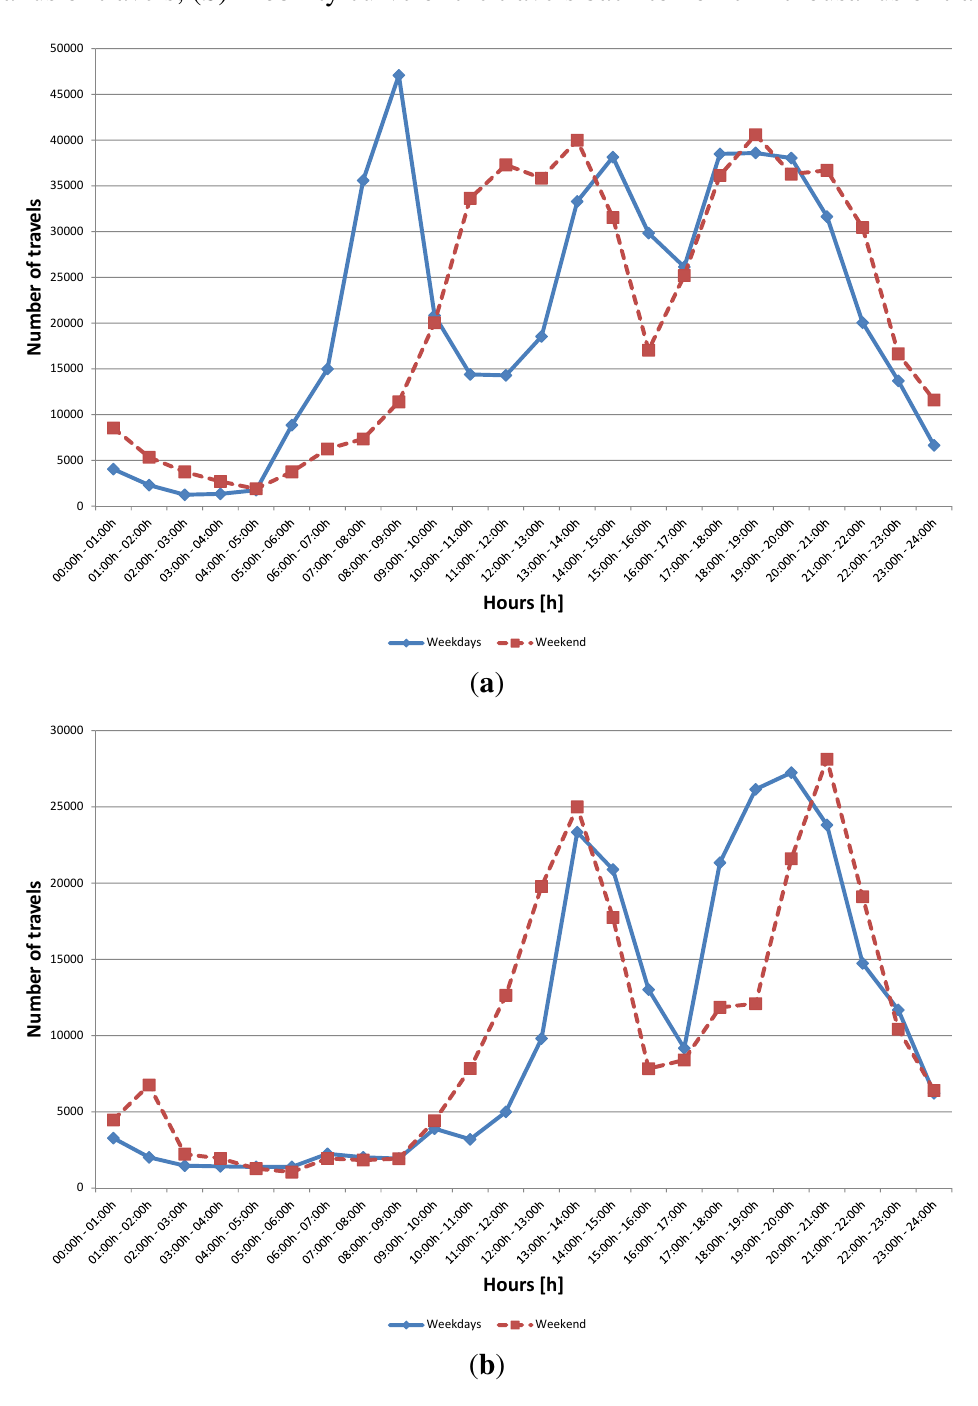
Figure 6. Mobility curves of the metropolitan area of Barcelona. ( a ) Mobility curve in thousands of travels; ( b ) Mobility curve of the travels back to home in thousands of